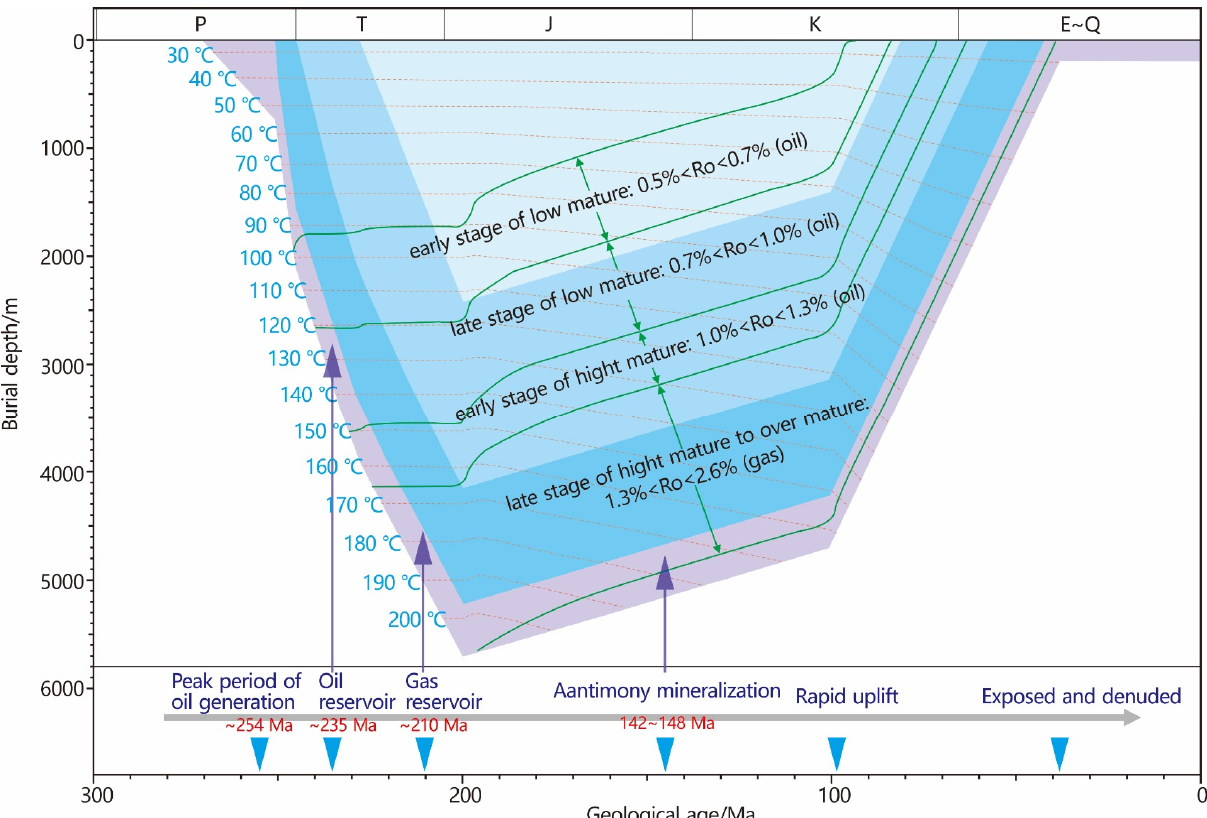
Figure 15. Simulation results of burial history, thermal history, and maturation history of Qinglong Paleo-oil reservoir show the time relationship between hydrocarbon evolution and antimony mineralization.